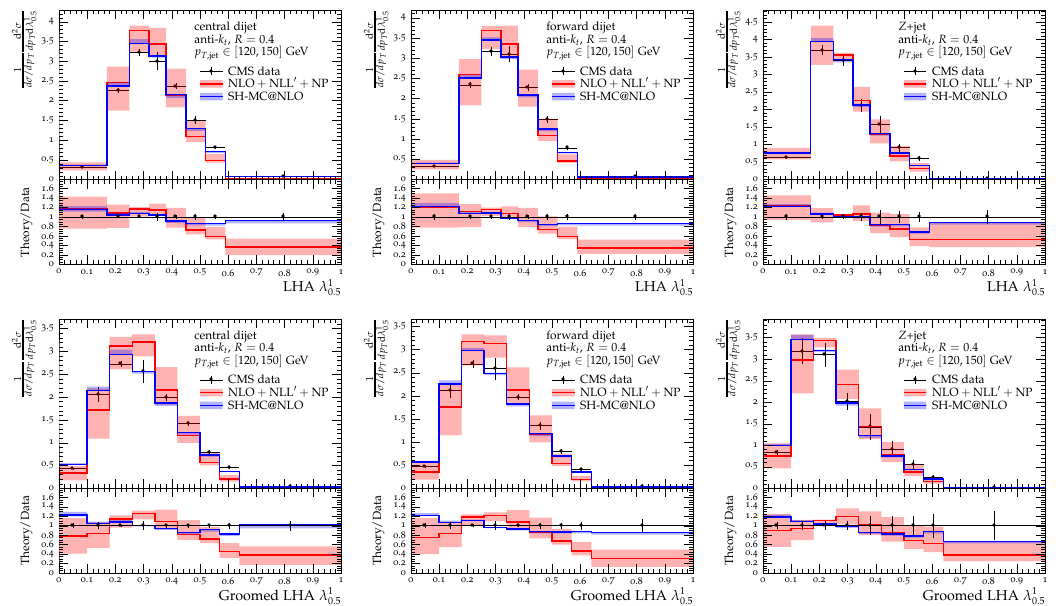
Figure 9. NLO + NLL 0 + NP and hadron-level SH-MC@NLO predictions for the differential cross section in the Les Houches Angularity λ 1 for ungroomed (top row) and groomed (bottom row) 0 . 5 R = 0 . 4 anti- k t jets with p T, jet ∈ [120 , 150] GeV, compared to data from CMS [30]. The left and middle panel correspond to the central and forward jet in dijet events, respectively, the right one to the leading jet in Z +jet production. The NP corrections to the perturbative NLO + NLL 0 prediction have been obtained with the transfer-matrix